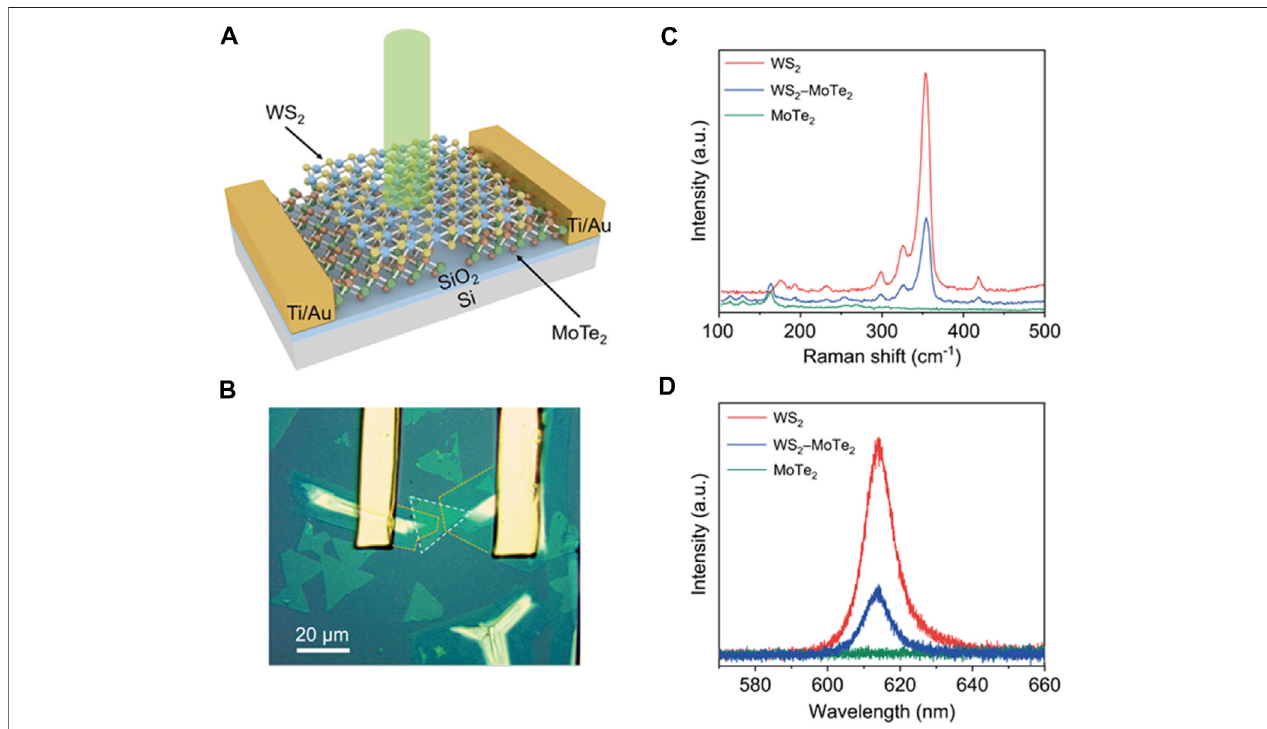
FIGURE 1 | Material characterizations of the MoTe 2 – WS 2 – MoTe 2 heterojunction device. (A) Schematic showing the APD composed of a monolayer WS 2 fl ake overlaid onto two few-layer MoTe 2 fl akes. The green cylinder delegates the incidence light. (B) Optical microscope image of the fabricated MoTe 2 – WS 2 – MoTe 2 heterostructure.TheWS 2 regionismarkedwithwhitedashed lines.TheMoTe 2 regionsaremarkedwithyellowdashedlines. (C,D) Raman (C) andPL (D) spectraofthe MoTe 2 – WS 2 – MoTe 2 heterostructure. The spectra are collected from the monolayer WS 2 (red), few-layer MoTe 2 (green), and WS 2 – MoTe 2 heterojunction (blue) regions. The excitation laser is of 532-nm